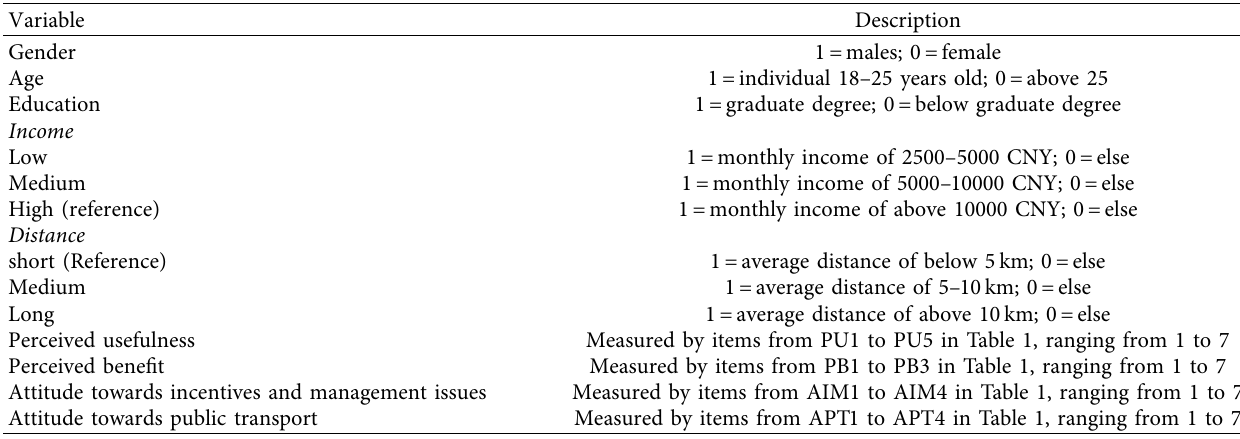
Table 3: Model variables.